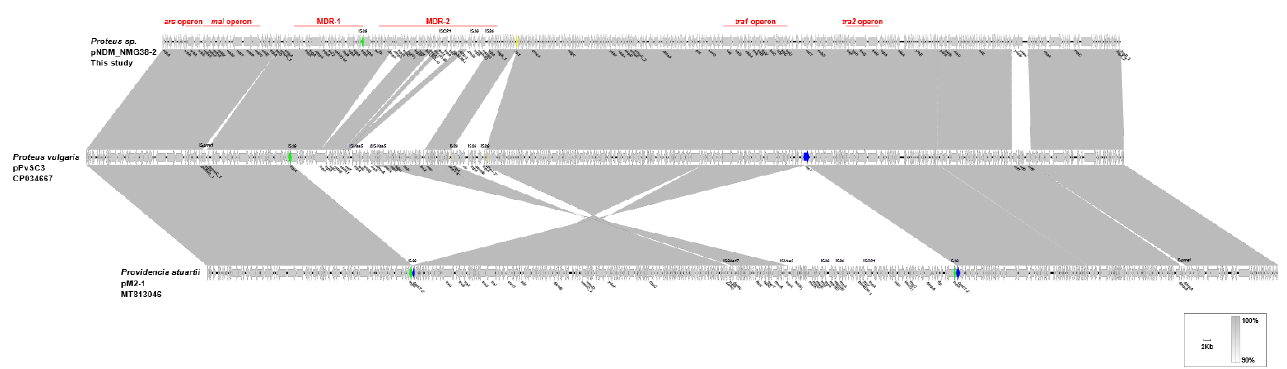
Figure 2. Circular comparisons of pNDM_NMG38-2 with pPvSC3 and pM2-1. pNDM_NMG38-2 was used as a reference to compare with other plasmids. The outer circle with red arrows denotes the annotation of reference plasmid, with arrows indicating deduced ORFs and their orientations. Gaps indicate regions that were missing in the respective plasmid compared to the reference plas- mid. Key backbone genes are indicated in green.